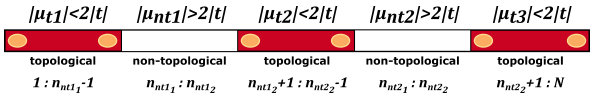
Figure 8: A Kitaev chain nanowire separated into five segments - three topological segments (red) and two non-topological segment (white). The total number of sites is N and the non topological segments range between sites n to n for non- nt 1 1 nt 1 2 topological segment 1, and n to n for non-topological segment 2. There are nt 2 1 nt 2 2 six MZM’s (yellow circles) on this wire - three pairs localized at the edges of the three topological